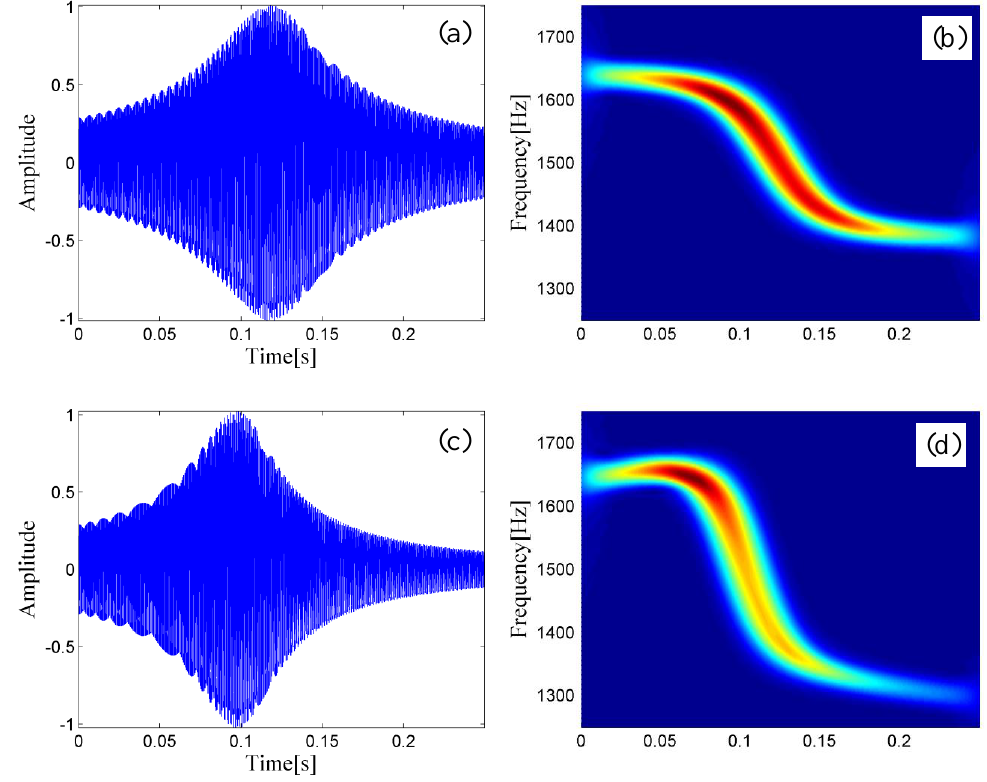
Figure 6. Two PMDWs generated by the invented PMDW generator. ( a ) The waveform of the PMDW generated with the model parameters set of [1,500, 340, 1, 4, 30, [0]] and ( b ) its STFT spectrum; ( c ) The waveform of the PMDW generated with the model parameters set of [1500, 340, 1, 4, 30, [100]] and ( d ) its STFT